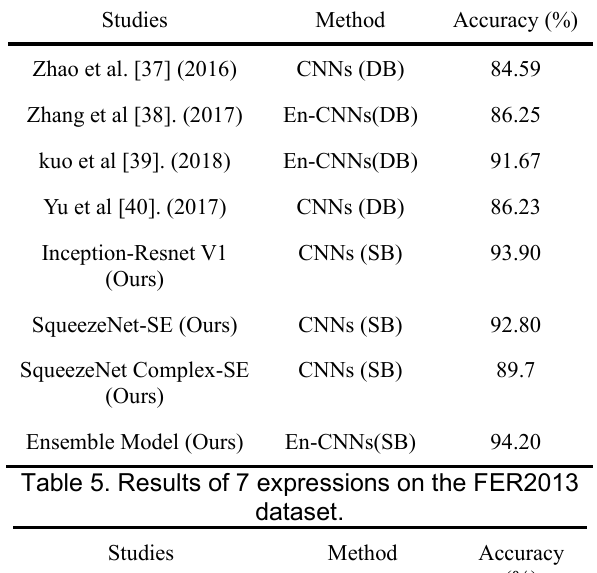
Table 4. Results of 6 expressions on the Oulu- CASIA dataset. (DB: dynamics-based, SB: Static-